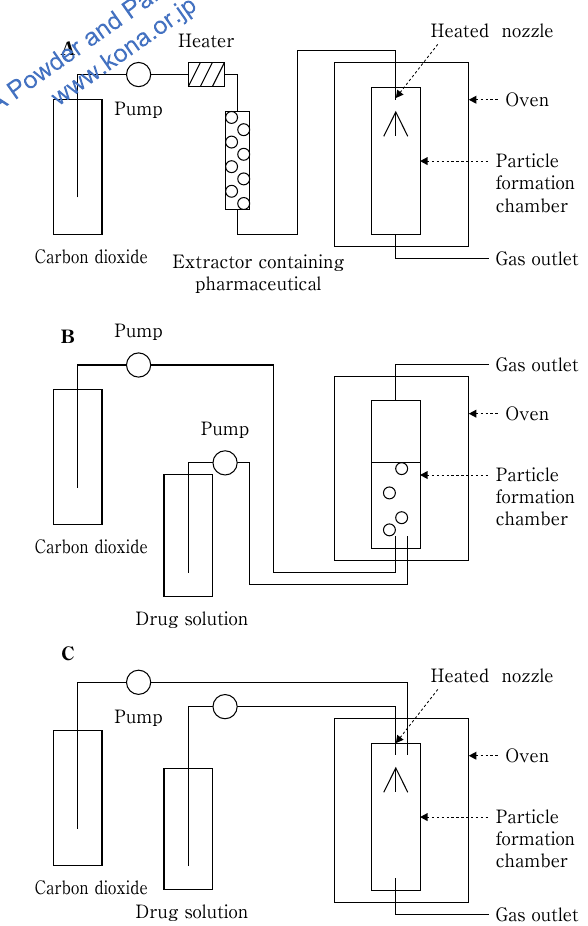
Fig. 5 Schematic diagrams of the (A) RESS, (B) GAS, and (C) PCA/ SAS/ASES